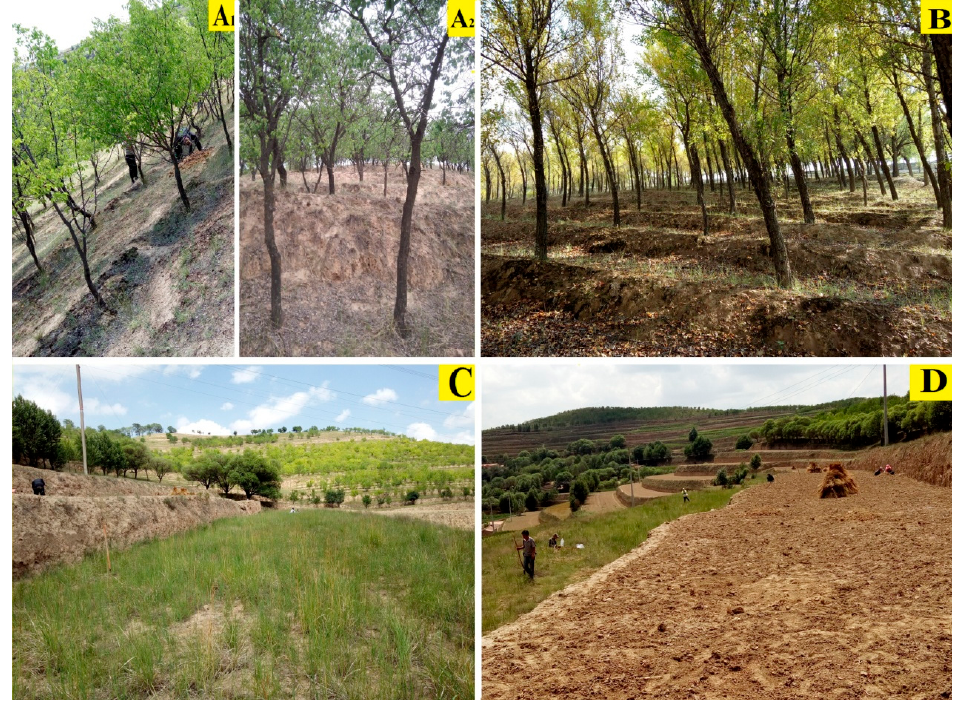
Figure 2. Sampled treatments in the study. A 1 : 16-year-old apricot stand; A 2 : 40-year-old apricot stand; B : 40-year-old poplar stand; C : Abandoned treatment; D : Cultivated treatment. In each sub-plot, soil samples were taken at depths of 0–0.1 m, 0.1–0.2 m, 0.2–0.4 m, 0.4–0.6 m,